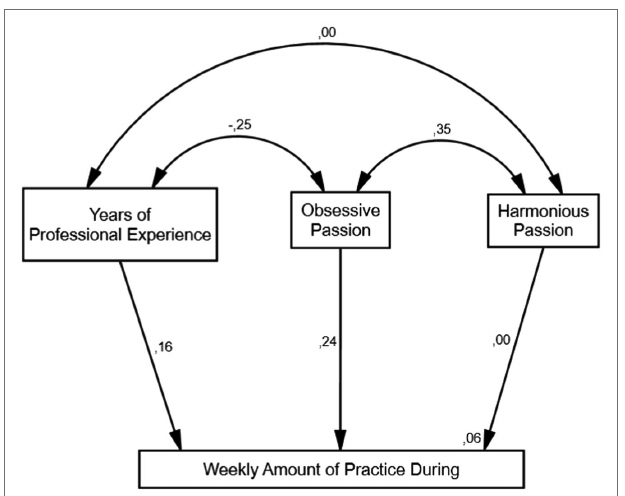
FIGURE 2 | Model during the COVID-19 pandemic for Europe.